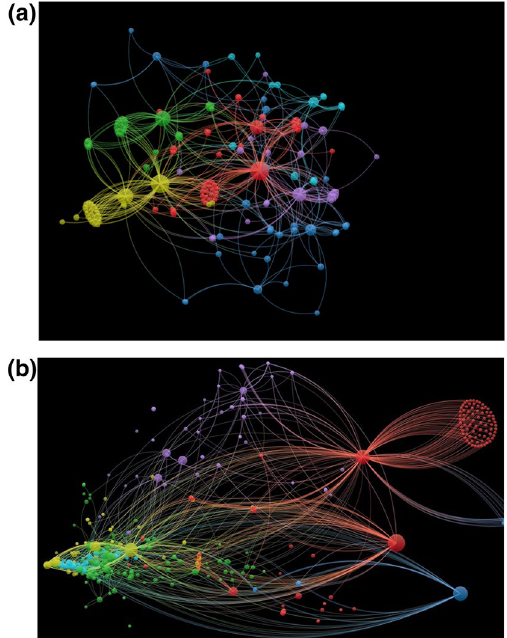
Fig. 2 The followers’ network of Twitter account of a the University of Washington Virology and b World Health Organization (up to